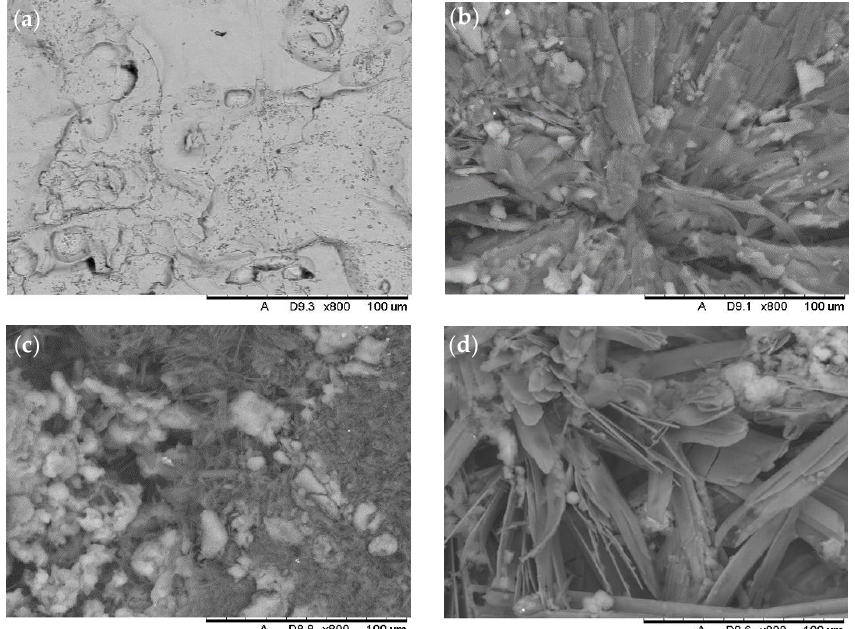
Figure 2. SEM images of fabricated coatings after immersion ( a ) uncoated, ( b ) formulation 1 (ethanol, 0.05 M stearic acid and micro-SiO 2 ) for 360 min, ( c ) formulation 2 (IPA, 0.05 M stearic acid and micro-SiO 2 ) for 360 min and ( d ) formulation 3 (ethanol, 2% wt. 1 M NaOH (aq), 0.05 M stearic acid